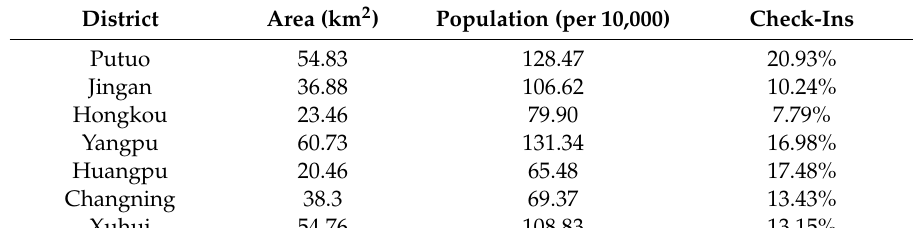
Table 2. Area and population in the districts.